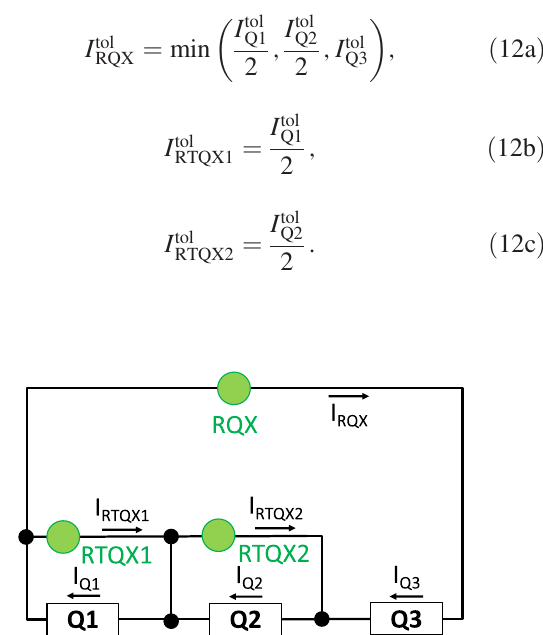
FIG. 6. Powering logic of the triplets. The white rectangles indicate the three triplet quadrupoles (Q1, Q2, Q3) and the three power-converters (RQX, RTQX1, RTQX2) are displayed as the green